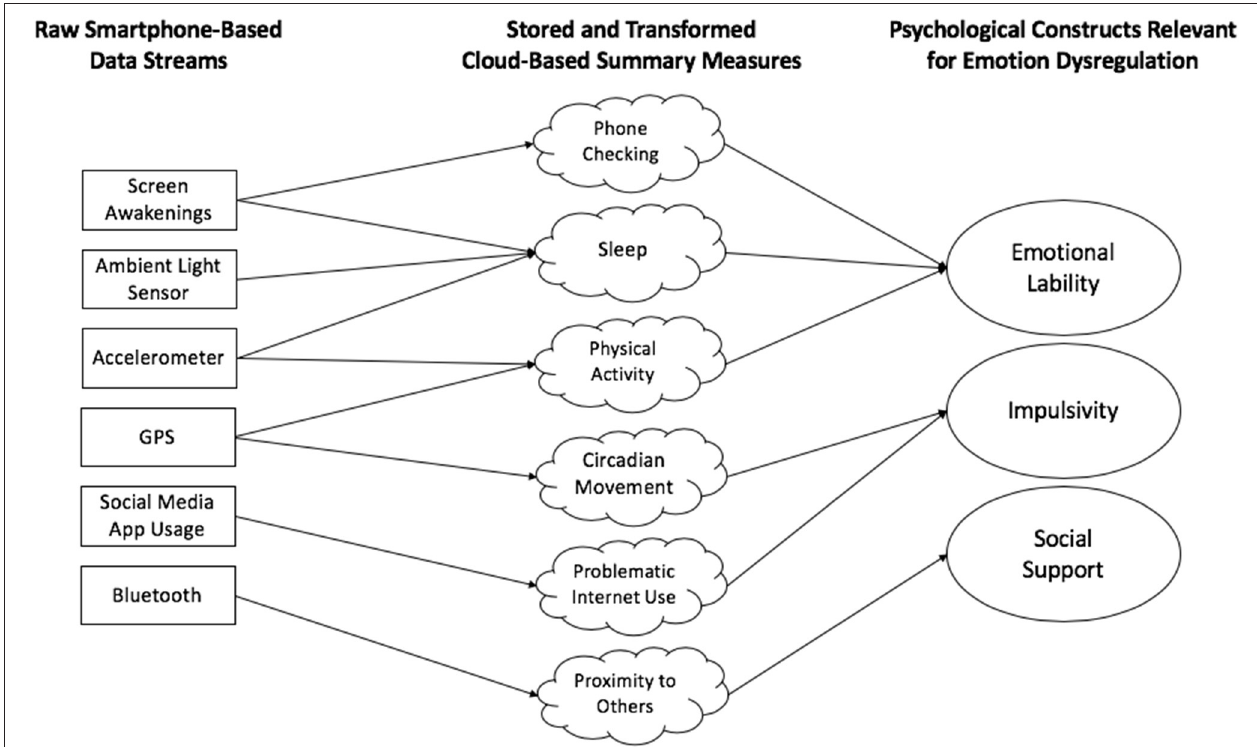
FIGURE 1 | Conceptual illustration of current smartphone-based passive monitoring methods. Raw data streams are collected directly from smartphones and then converted into more useful variables/measures through cloud-based interfaces. These measures convey meaning about relevant constructs—in this case, emotion dysregulation. Note that, for simplicity, this figure conveys merely a small sample of current possible data streams and variables, and many others